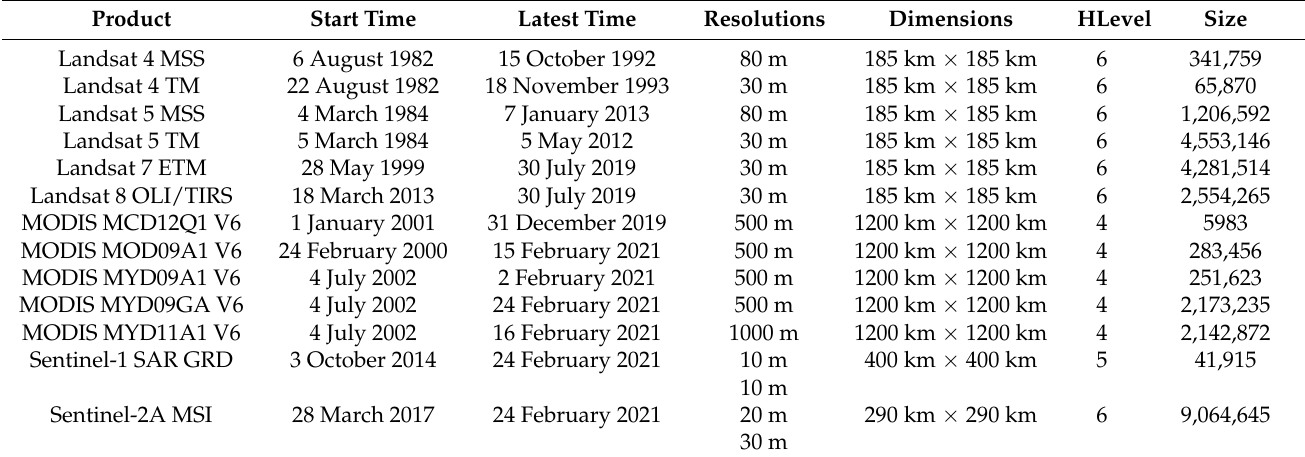
Table 1. Popular products in